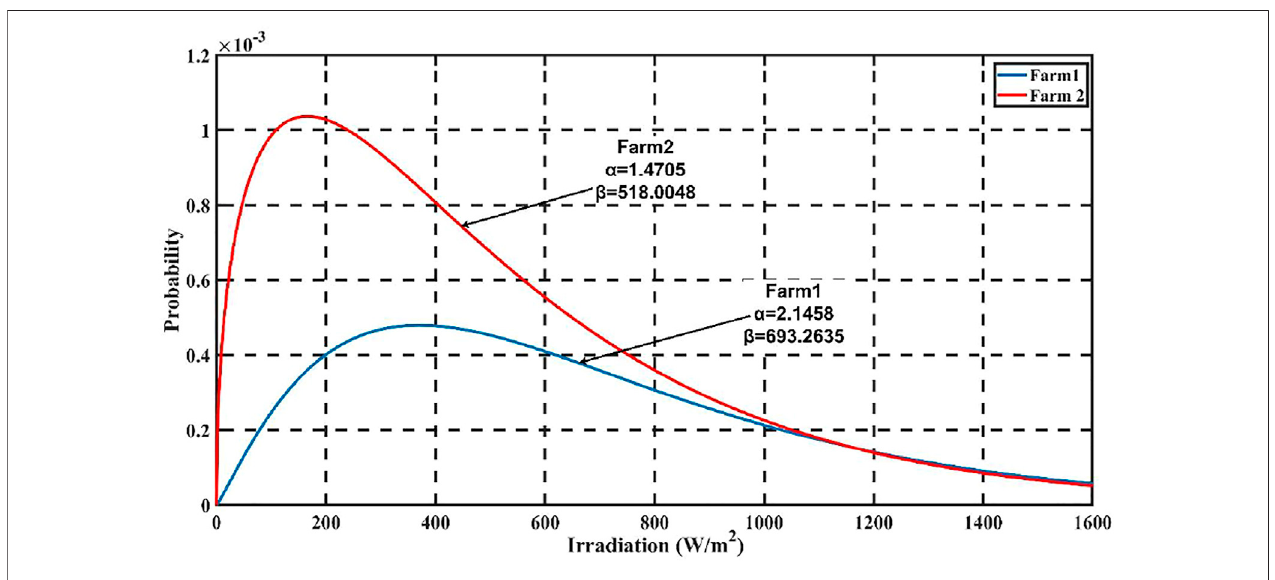
FIGURE 1 | PDF of solar irradiation for two farms.